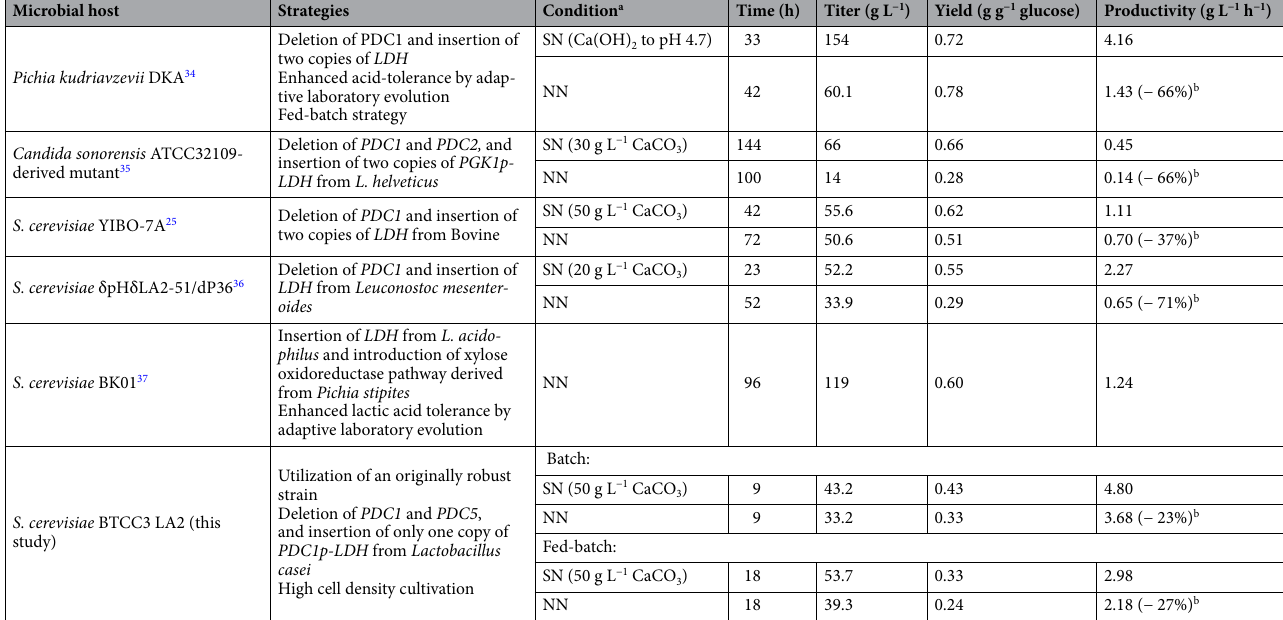
Table 2. Comparison of lactic acid fermentation with and without a neutralizing agent from several studies. a SN semi-neutralized, NN non-neutralized. b The percentage values indicate the drop in productivity when no calcium carbonate was added at the beginning of fermentation.